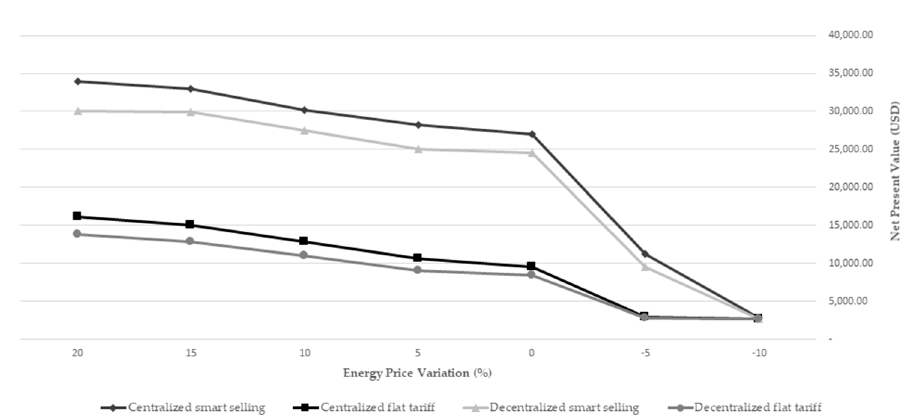
Figure 2. Simple payback period under assumptions of the intelligent and flat energy selling price.